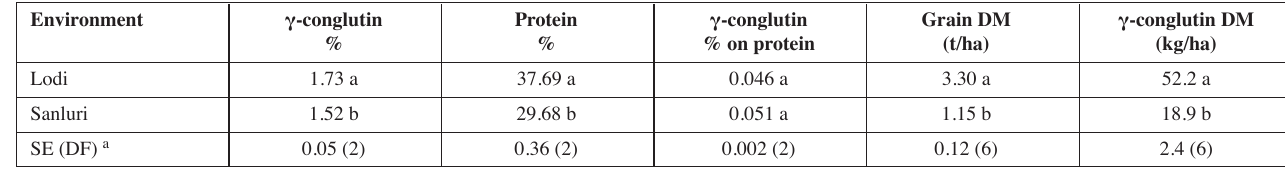
Tab. 4: Mean values over five white lupin genotypes of seed γ-conglutin and protein contents (in % w/w) measured by HPLC and Kjeldahl methods, respec - tively, and grain and γ-conglutin dry matter (DM) yield, for two contrasting cropping environments (Lodi, northern Italy; Sanluri, Sardinia) in the season 2013-14.